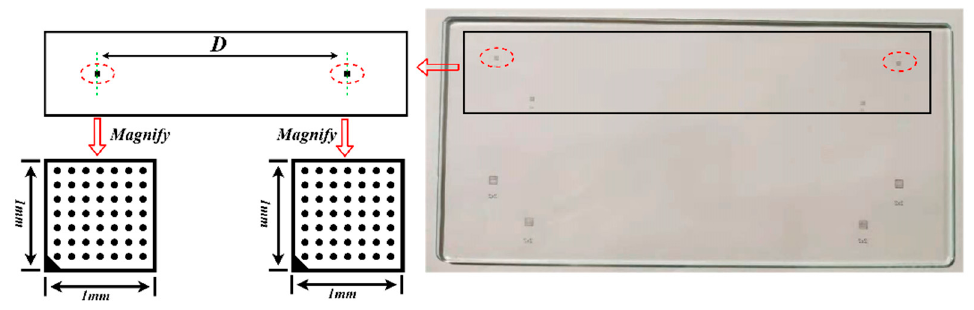
Figure 9. Calibration board. Table 1. Inherent parameters of the cameras and